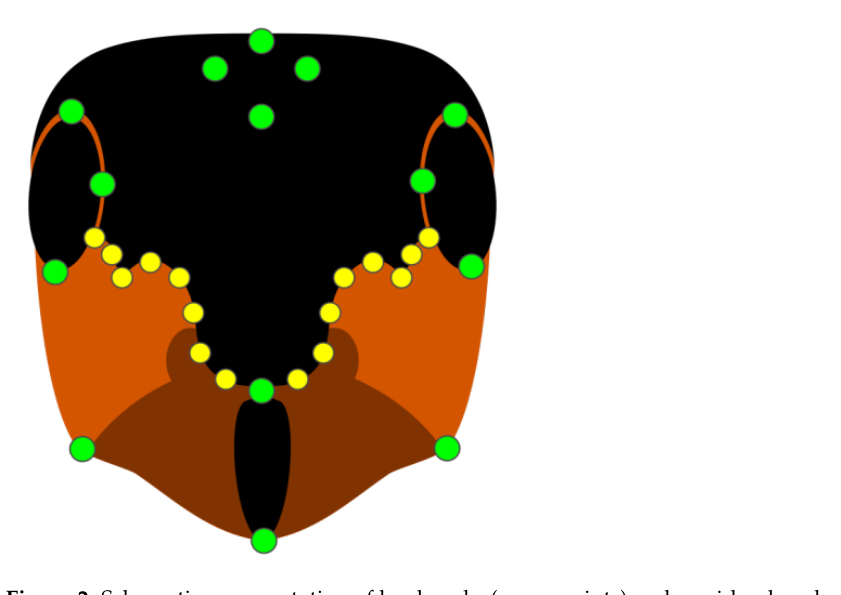
Figure 2. Schematic representation of landmarks (green points) and semi-landmarks (yellow points) used in the analysis.